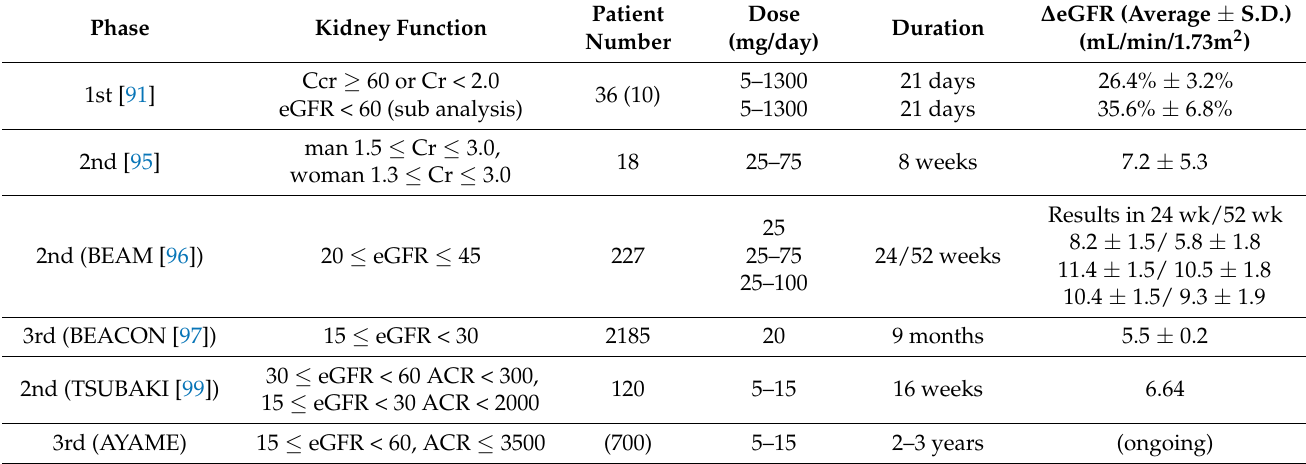
Table 2. Results of clinical studies of bardoxolone methyl on diabetic kidney